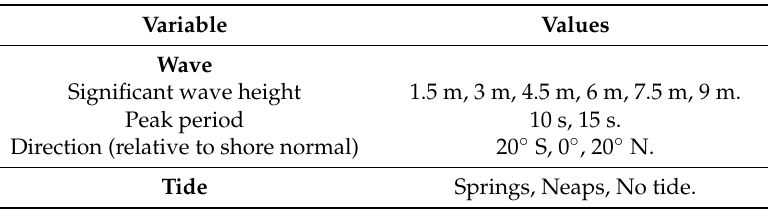
Table 2. Synthetic wave–tide condition